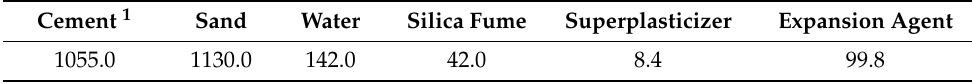
Table 4. Mixture composition of grout (unit: kg/m 3 ).